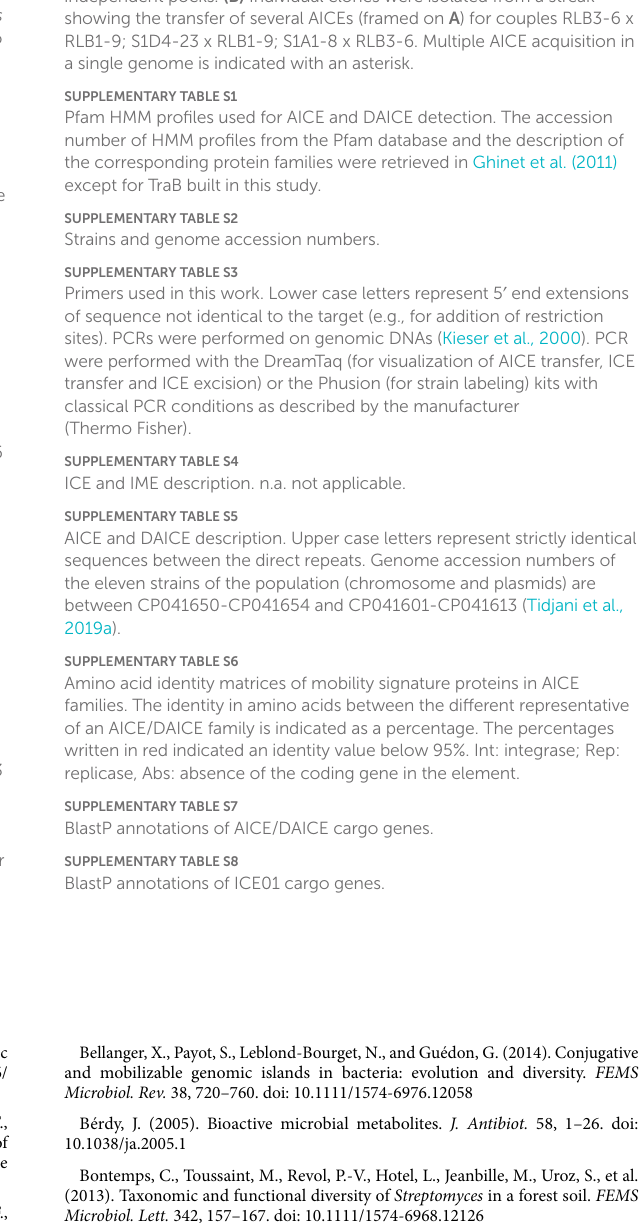
SUPPLEMENTARY TABLE S4 ICE and IME description. n.a. not applicable. SUPPLEMENTARY TABLE S5 AICE and DAICE description. Upper case letters represent strictly identical